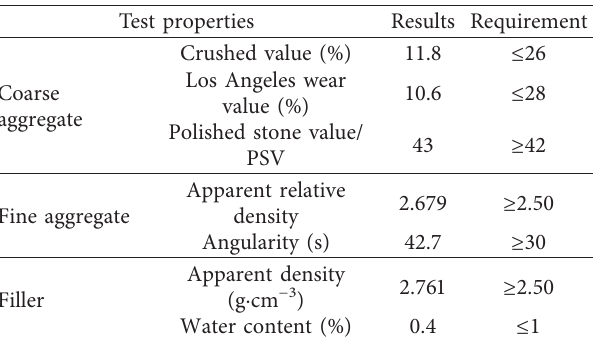
Table 2: Physical properties of aggregate and